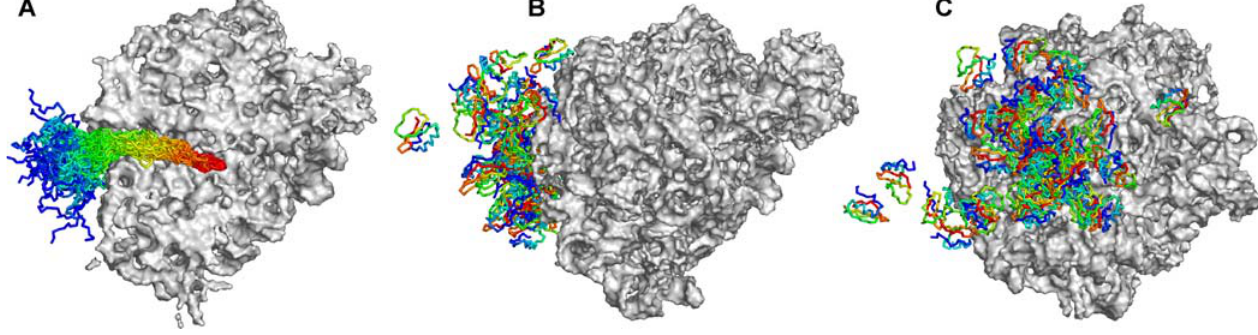
Figure 4. Fifty Coupled Synthesis–Folding Simulations of CI2 (A) Snapshots showing all 50 coupled synthesis–folding simulations of CI2 at the moment at which the final residue is released. (B) and (C) Snapshots for the same system at the moment that the native conformations are achieved; the two views are related by a 90 8 rotation around the vertical axis. Note that in this simulation model, the proteins do not diffuse far from the ribosome before completing folding. DOI: 10.1371/journal.pcbi.0020098.g004